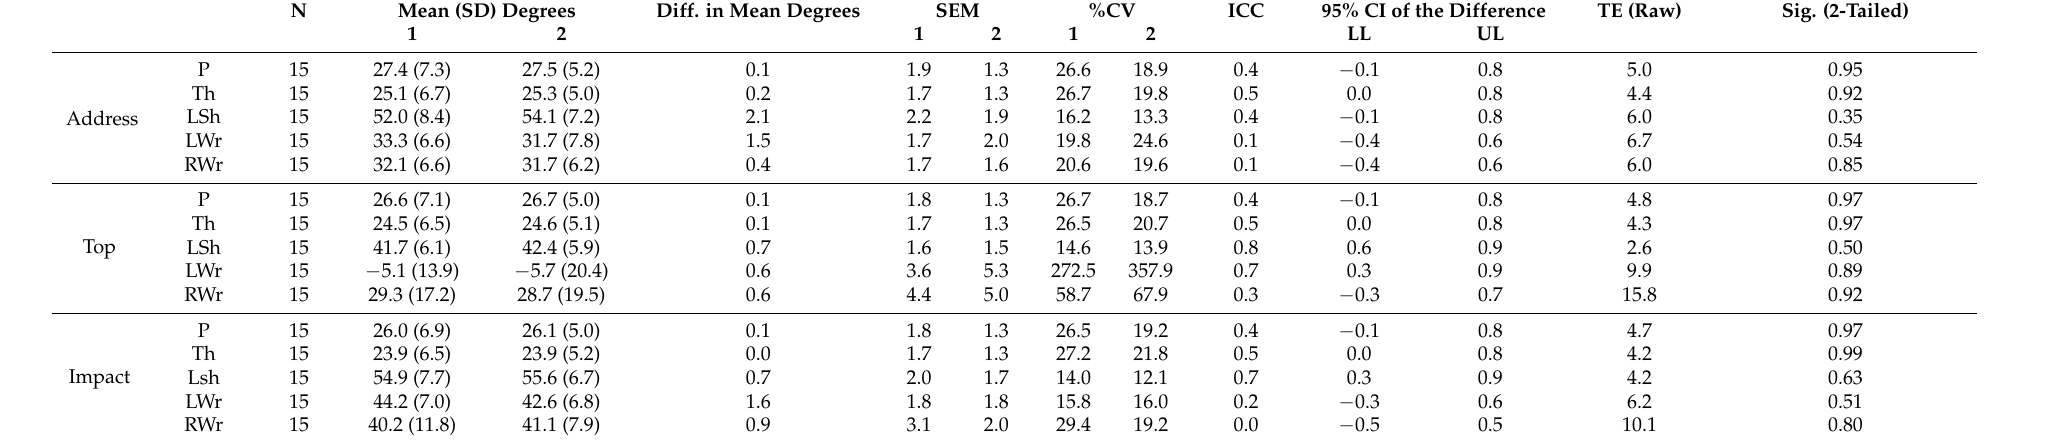
Table 3. Reliability of the Polhemus Liberty system for segment and joint angular kinematics in the anterior/posterior axis.